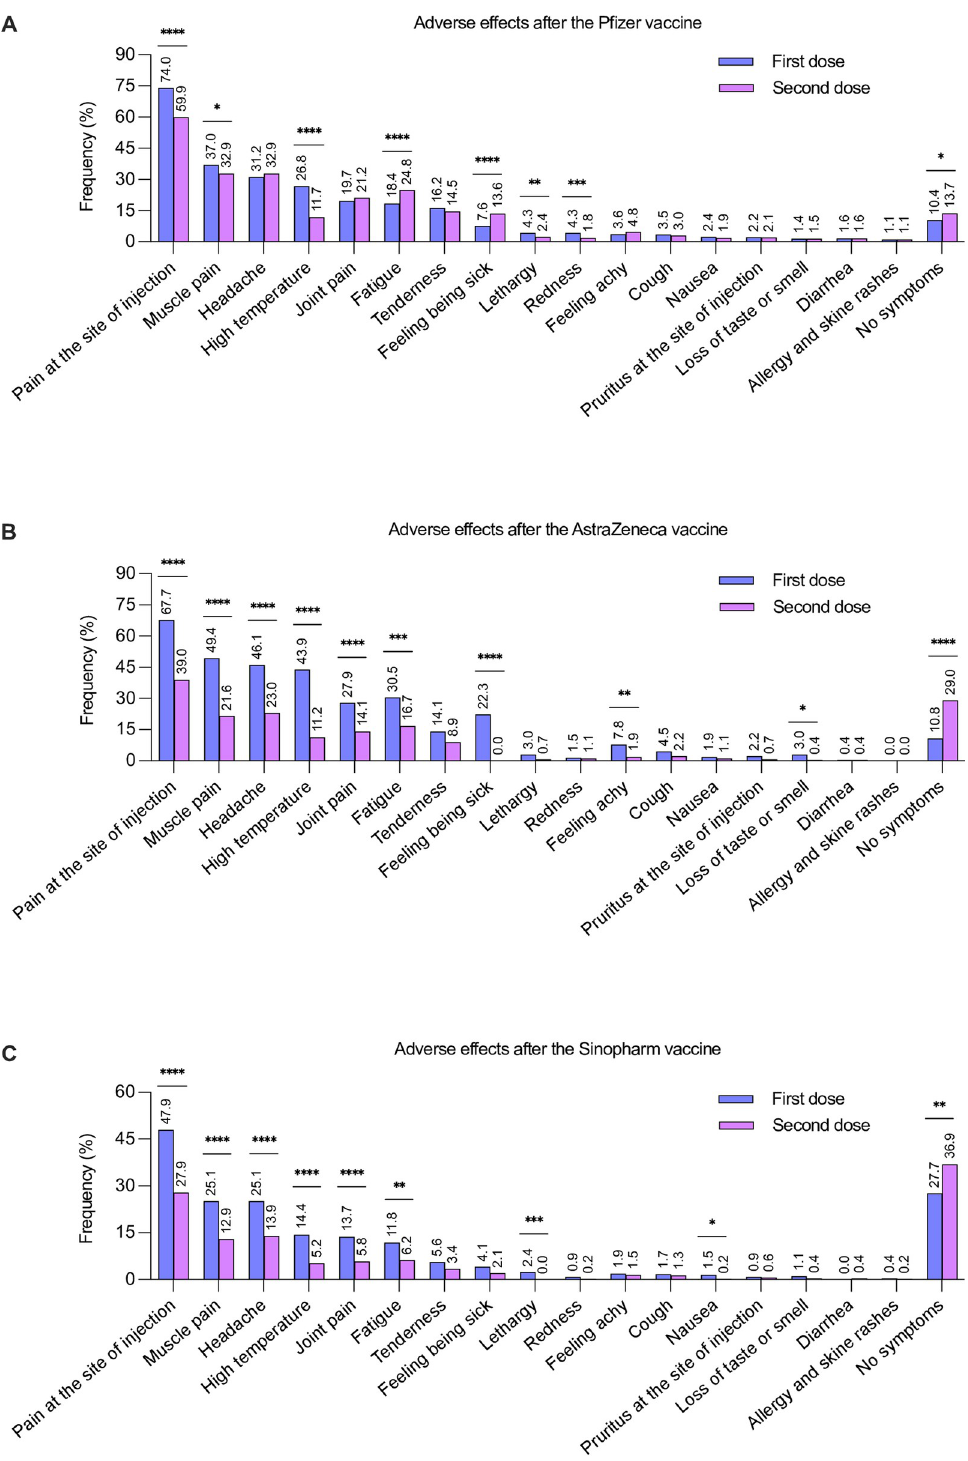
Fig 2. Prevalence of the adverse effects (percentage) associated with various vaccine types after the first dose and second dose. (A) Pfizer after the first and second dose, (B) AstraZeneca after the first and second dose, (C) Sinopharm after the first and second dose. Statistical analysis of the adverse effects associated with various vaccine types (first dose versus second dose) was performed using the chi-squared test. � p < 0.05, �� p < 0.01, ��� p < 0.001 and ���� p < 0.0001.